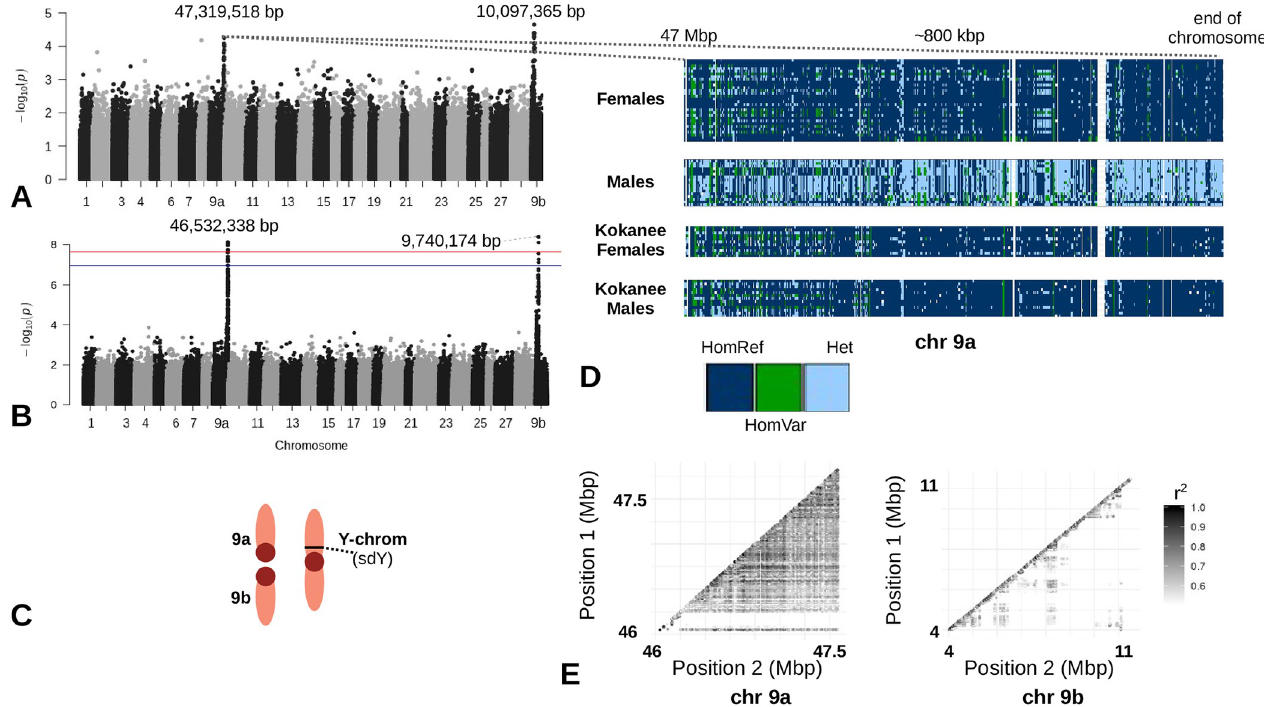
Fig 5. Sockeye salmon and kokanee sex chromosomes. A) A GWA between all known male and female sockeye salmon and kokanee salmon with the DAPC LD1 values as covariates. The two peaks (Chr. 9a and 9b) did not reach significance. B) A GWA between all individuals scored for the presence or absence of the sex-determining gene (red line indicates significance threshold). C) A depiction of the proposed X1 (9b), X2 (9a), and Y chromosomes. D) IGV was used to visualize variants on chromosome 9a with only minimal filtering for known females (no upper Columbia River kokanee), males (no upper Columbia River kokanee), Freshwater Fisheries Society of British Columbia female kokanee, and Freshwater Fisheries Society of British Columbia male kokanee. E) On the left, LD plot of chromosome 9a from 4.6 Mbp to the end of the chromosome (~2 Mbp) with a minimum LD threshold of r 2 = 0.5 for both plots. On the right, LD plot of chromosome 9b from 3.5 Mbp to 11.5